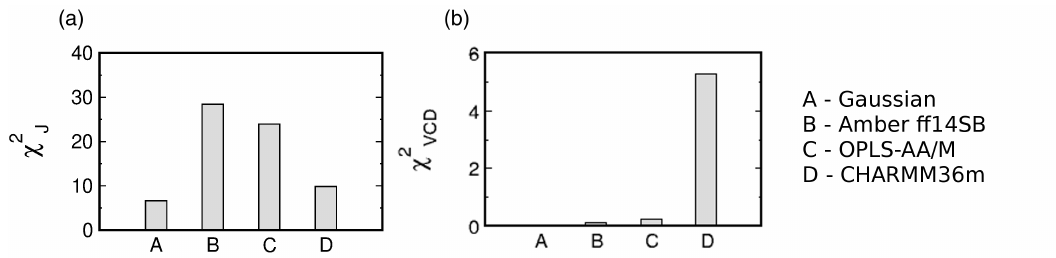
Figure 3. Assessment of the Gaussian model and three MD force fields with respect to their ability to reproduce the experimental data for the central glycine residue in cationic GGG by ( a ) χ 2 χ 2 values in ( b ) are multiplied by 10 7 for display VCD